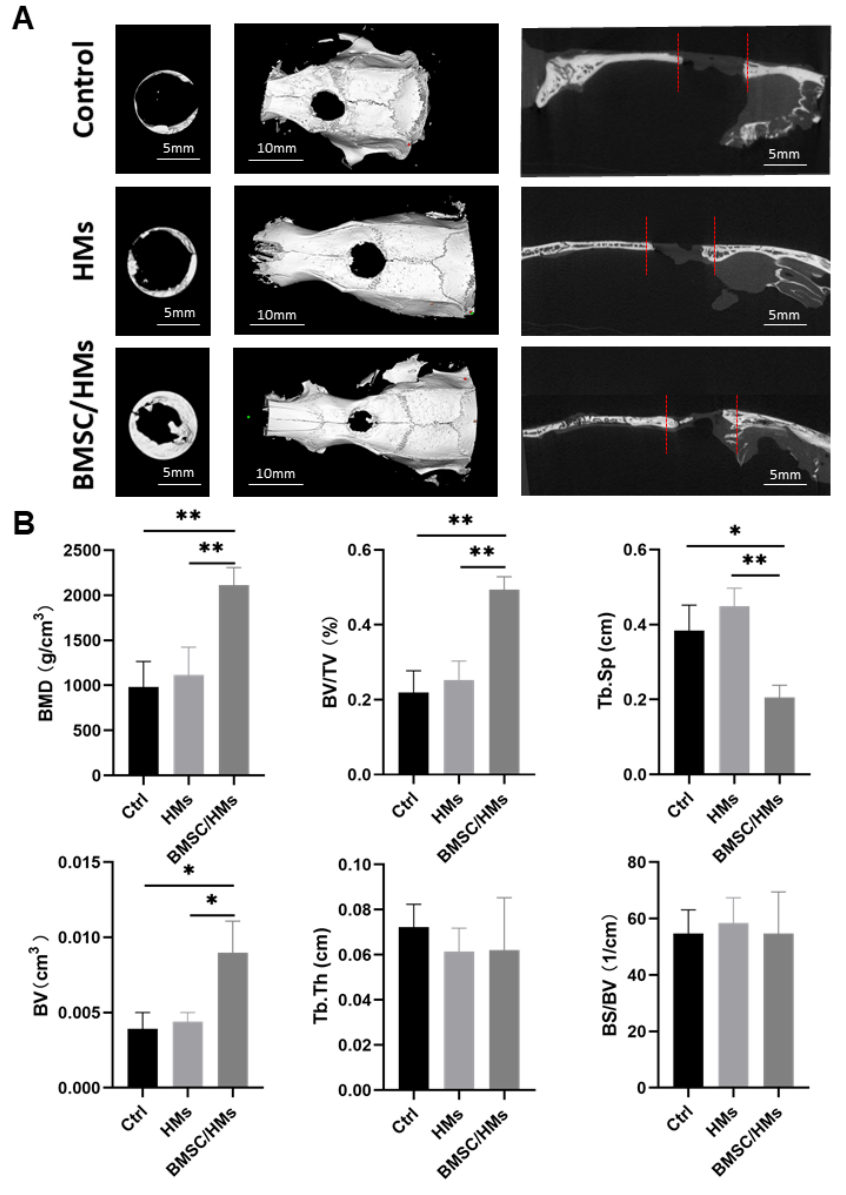
Figure 4. Evaluation of bone regeneration 8 weeks after surgery by micro-CT. ( A ) Micromorphometric analysis of large skull defects including superficial, three-dimensional, and sagittal views of micro-CT images after 8 weeks of surgery. ( B ) Micromorphometric bone parameters including BMD, BV/TV, Tb.Sp, BV, BS/BV, and Tb.Th analysis of control, HMs, and BMSC/HMs groups after 8 weeks of surgery (error bars, mean ± SD; * p < 0.05, ** p < 0.01; n = 3 per group).